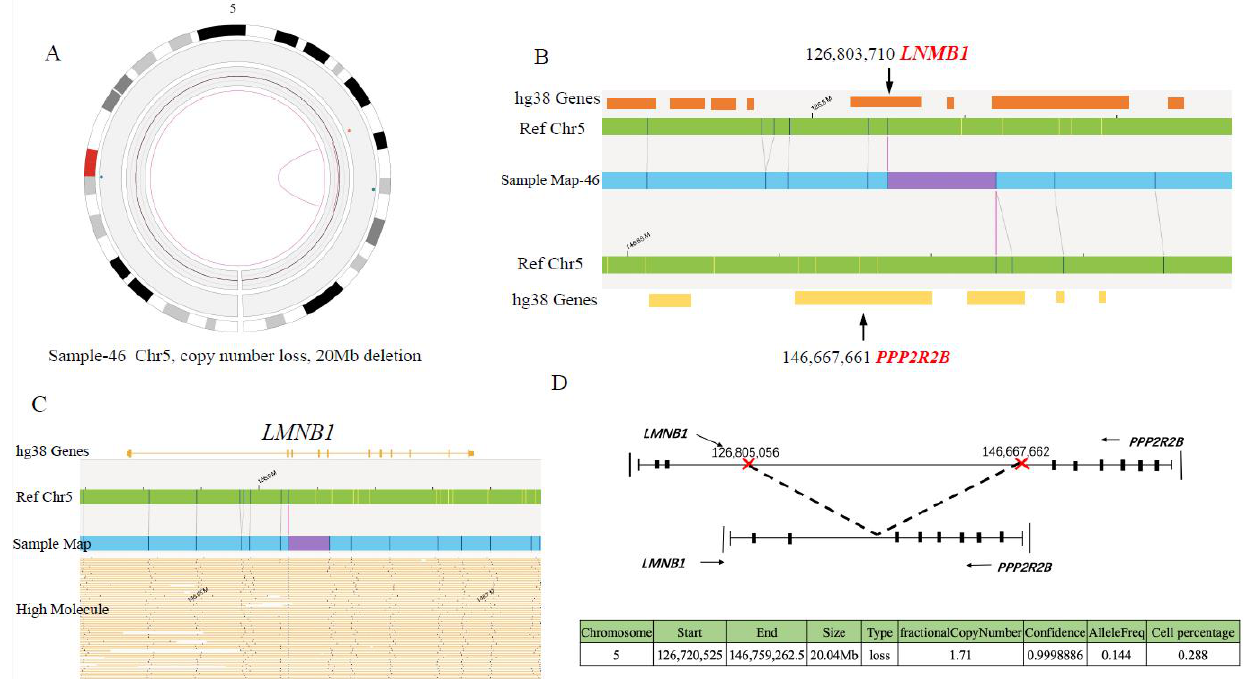
Figure 8. LMNB1-PPP2R2B fusion gene identified by OGM. ( A ) Zoom-in circus plot of chromosome 5 only, showing the fusion called by the SV and CNV tool. ( B ) Chromosome map view, navigated from circus plot, supports the existence of the fusion. The lower track shows the fusion call from the map, specifying the deletion between chr5:126,803,710 and chr5:146,667,661 (size: 20Mbp). ( C ) OGM provides direct evidence for LMNB1 :: PPP2R2B fusion: aberrant molecules supporting the translo- cation. ( D ) Diagram of LMNB1 :: PPP2R2B fusion pattern.